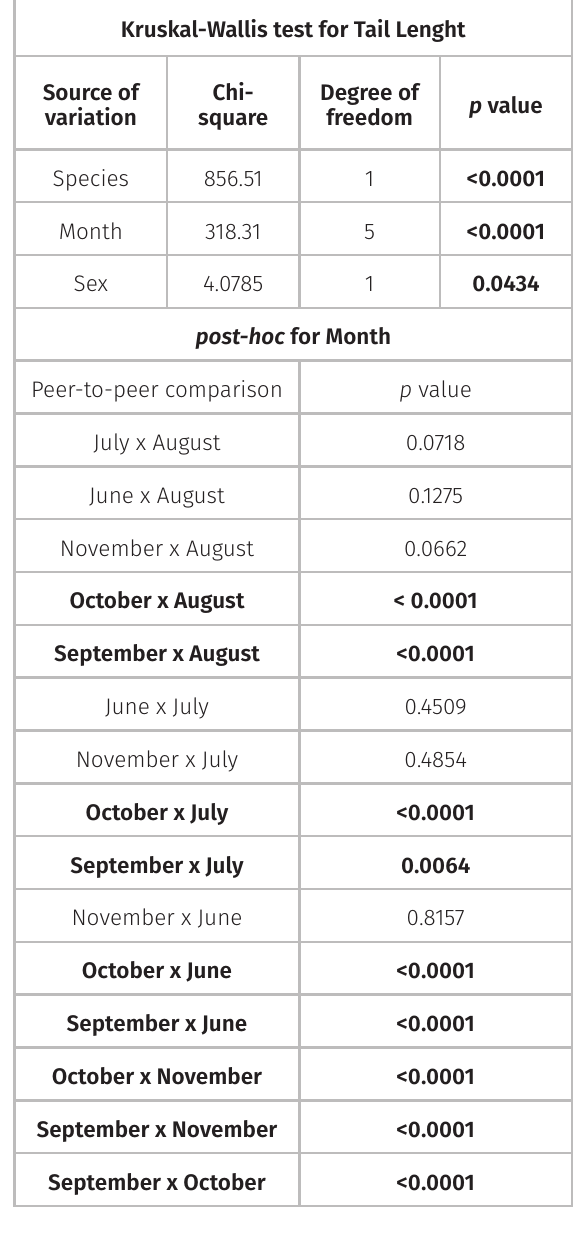
Table I. Statistical summary from Kruskal-Wallis tests considering tail length as the dependent variable and group factors by Species, Month and Sex analyzed separately. Post-hoc evaluation only performed for the time factor Month; bold values indicate statistical significance ( p